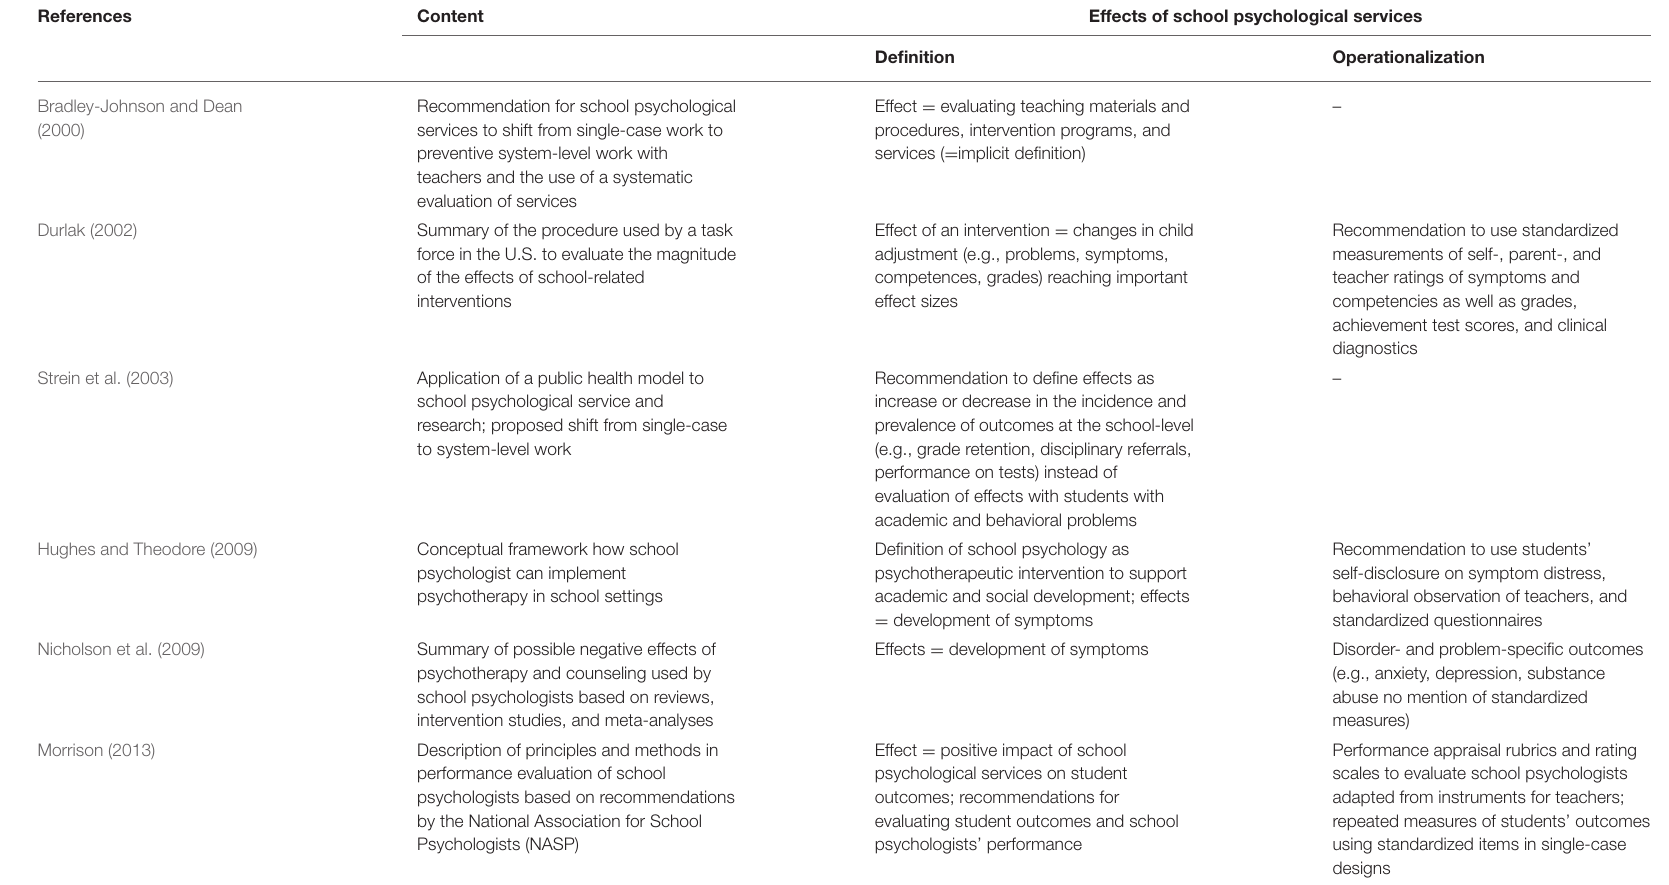
TABLE 3B | Summary of included theoretical or conceptual